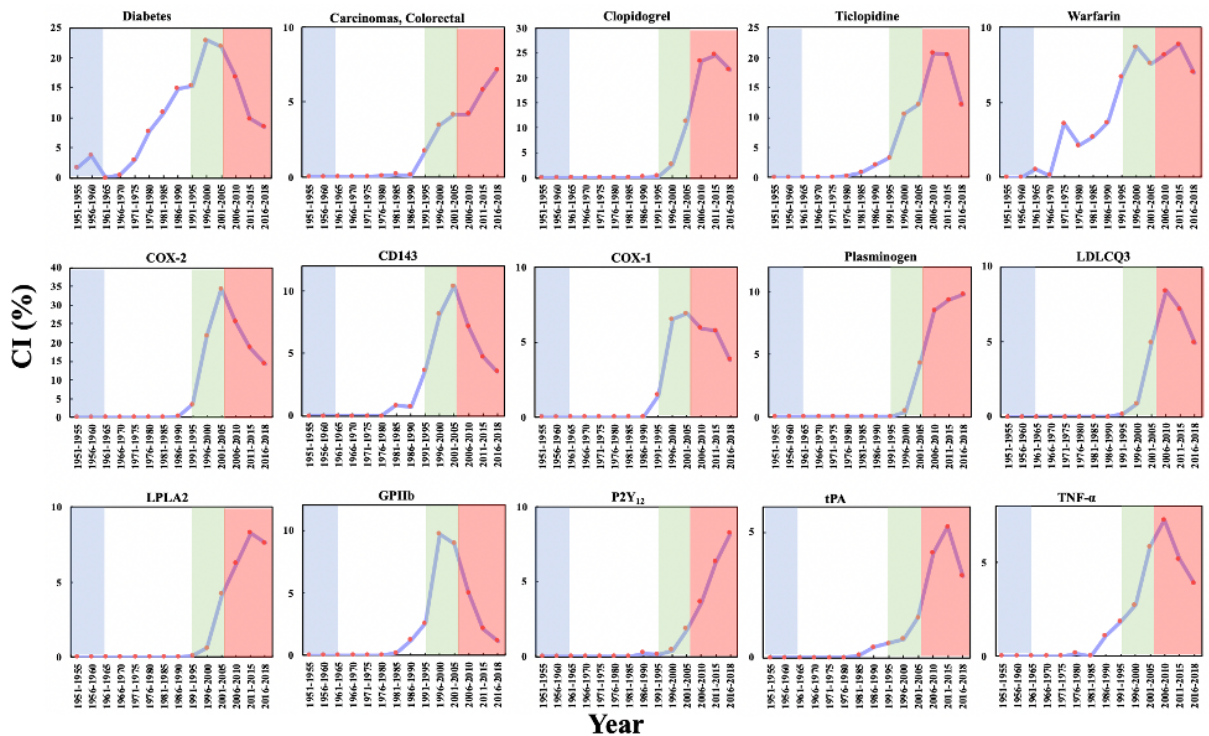
Figure 11. The Collaboration Index (CI) of the biomedical entities on repurposing aspirin for other diseases over time. The background colors show the 4 phases of aspirin